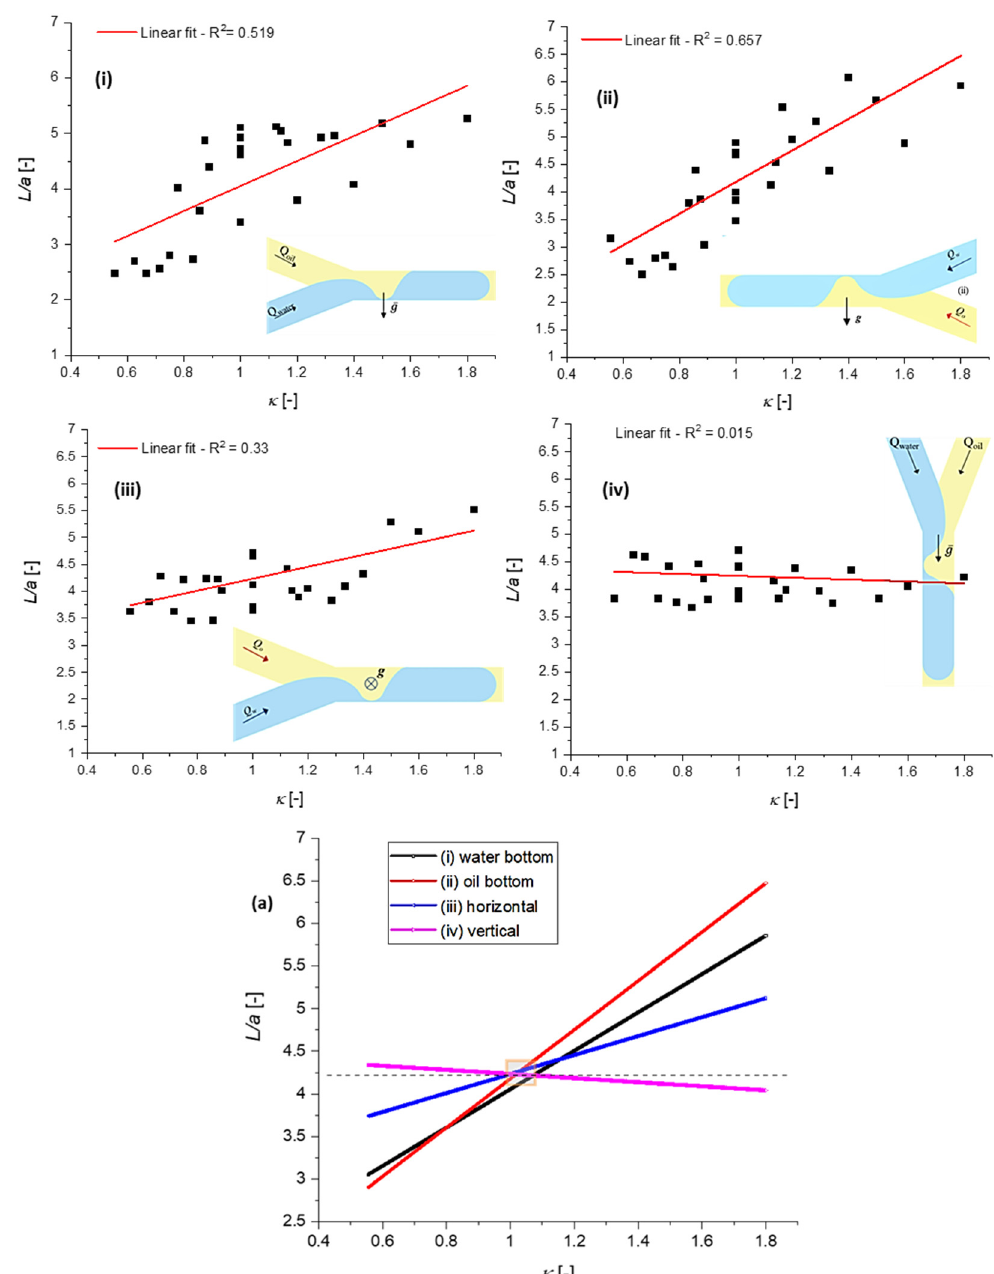
Figure 8. Nondimensional water-droplet length L = L / a as a function of microchannel orientation ( i – iv ); the dependence L ( κ ) for the tested configurations ( a